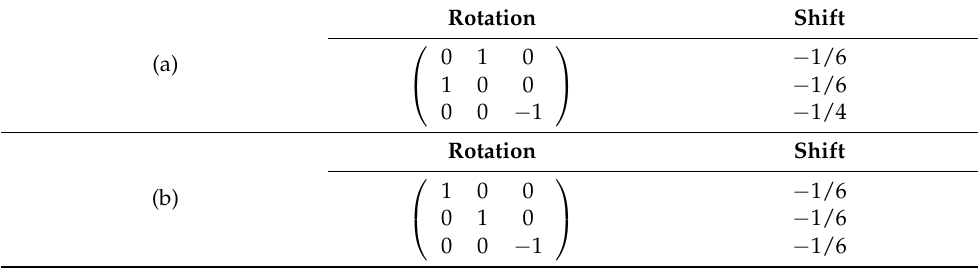
Table 3. Transformation of one phase in (011) relative to another phase; (a) Figure 1f and (b) Figure